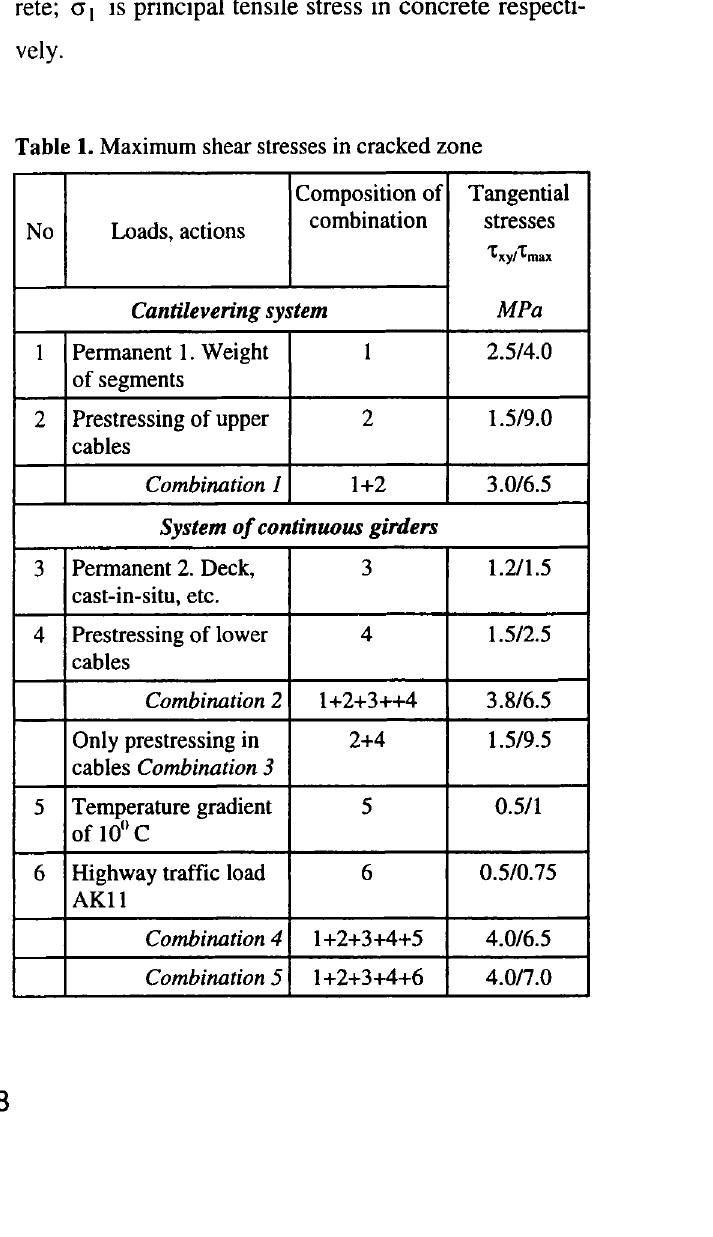
Table 1. Maximum shear stresses in cracked